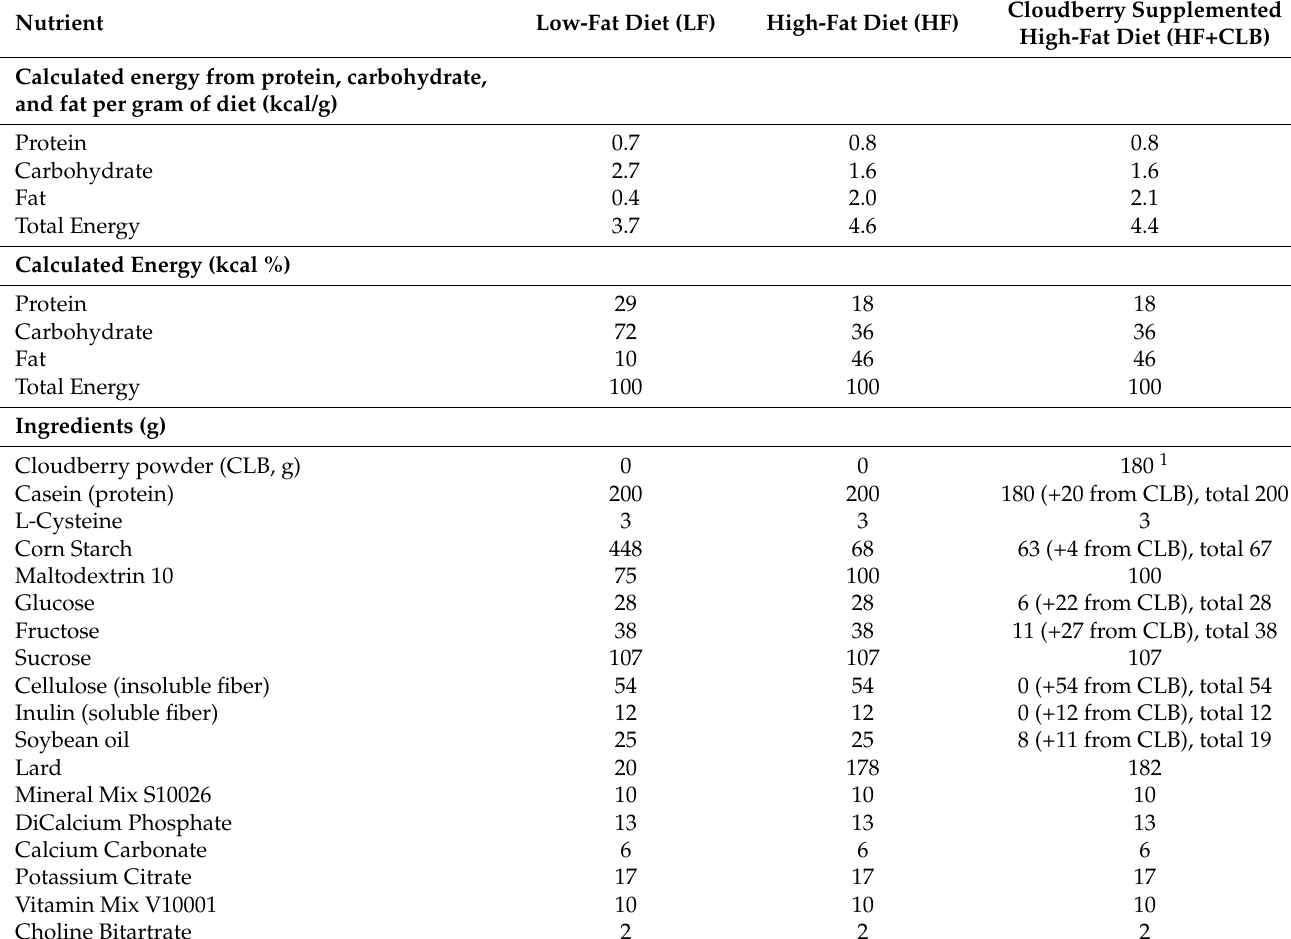
Table 1. The nutritional composition of the experimental